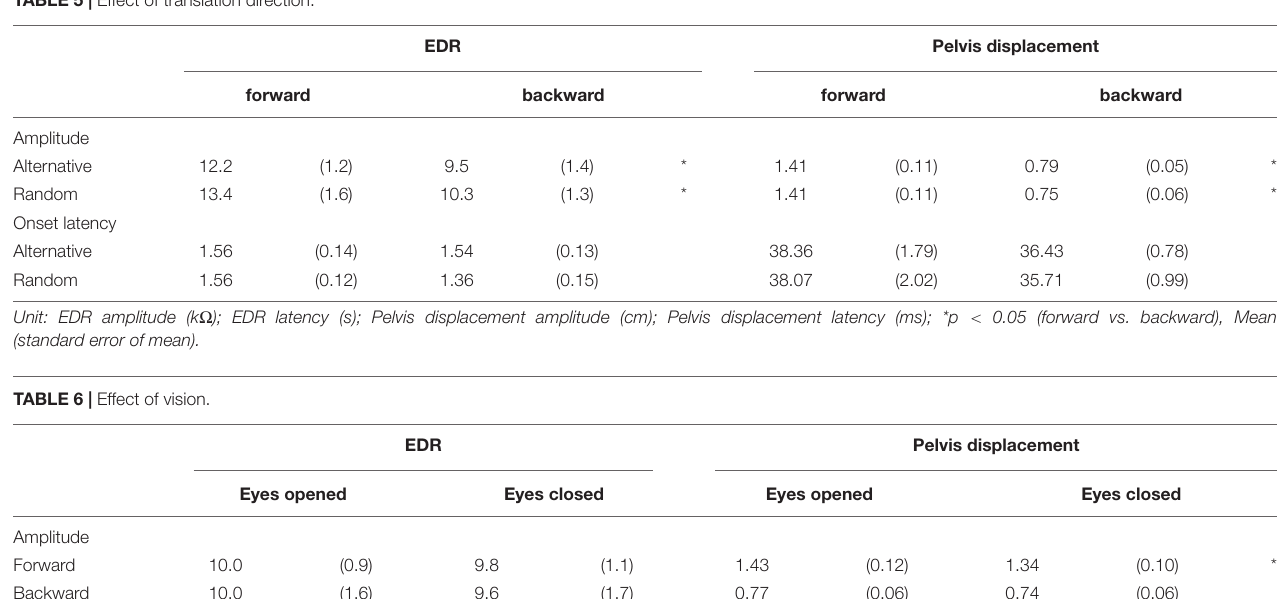
TABLE 5 | Effect of translation direction.